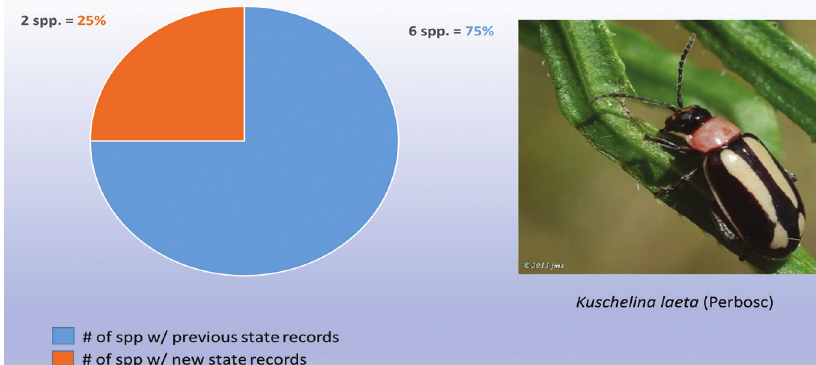
Figure 5. Kuschelina Bechyné new state records versus previously recorded state records.